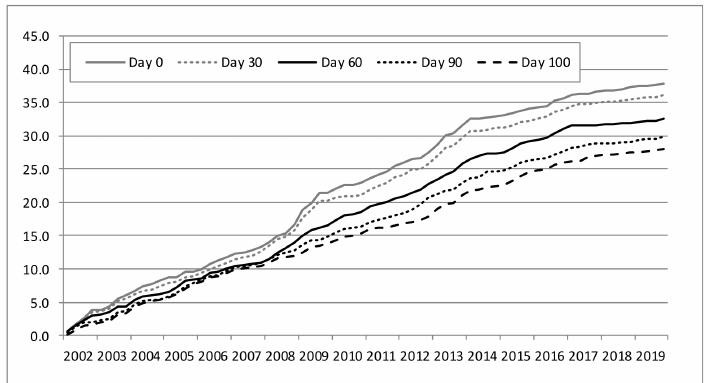
Figure 2. Cumulative absolute out-of-sample forecast error of the median of Models 1 to 6 progres- sively updated with more data over the current quarter (percentage points, 2002Q1–2019Q4).